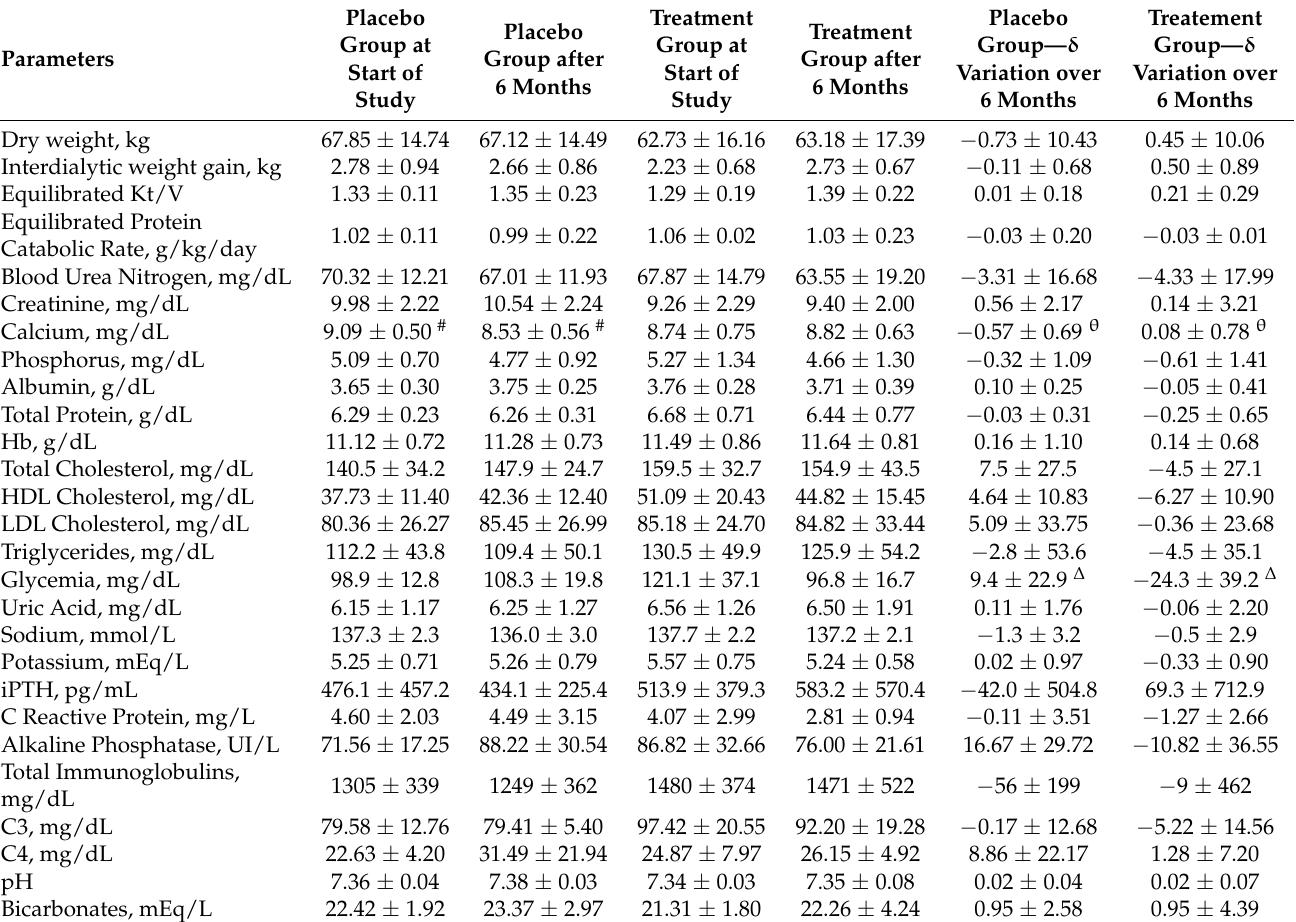
Table 2. Pre-Dialysis Blood Chemistry Analysis of Treatment and Placebo Groups and Differences observed in Temporal Inter-Study ( δ ) and Intra-Study Group